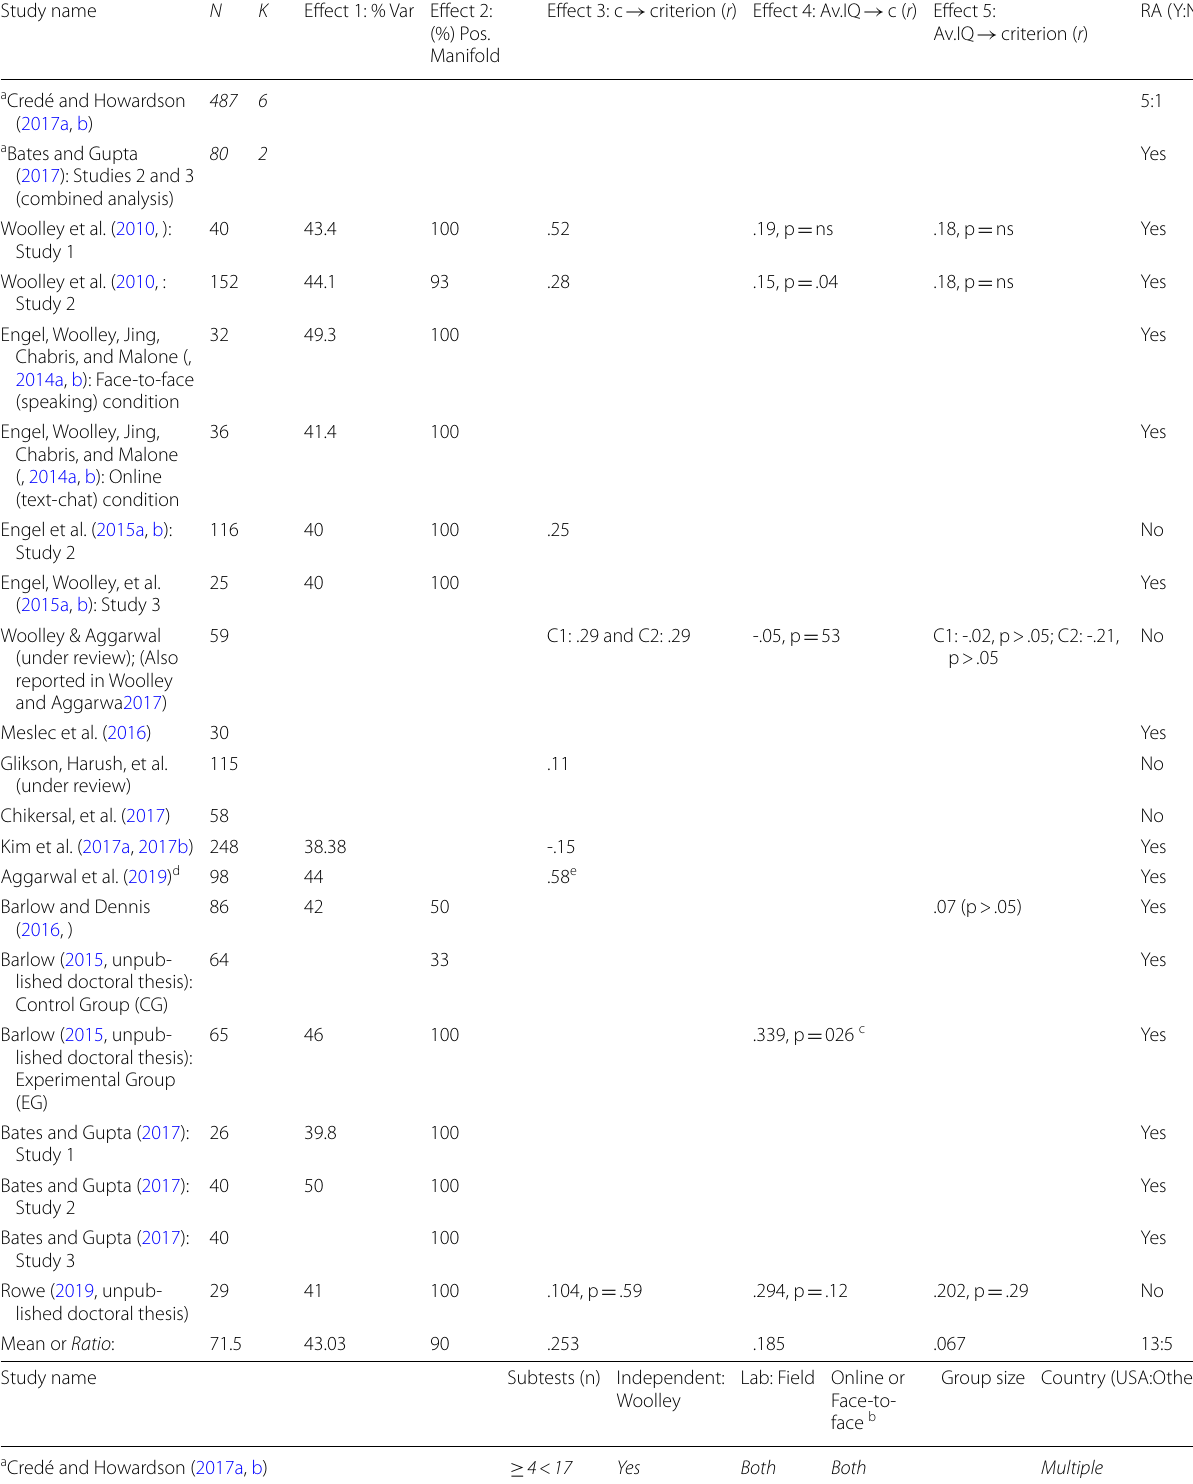
Table 1 Summary of Empirical Studies on Collective